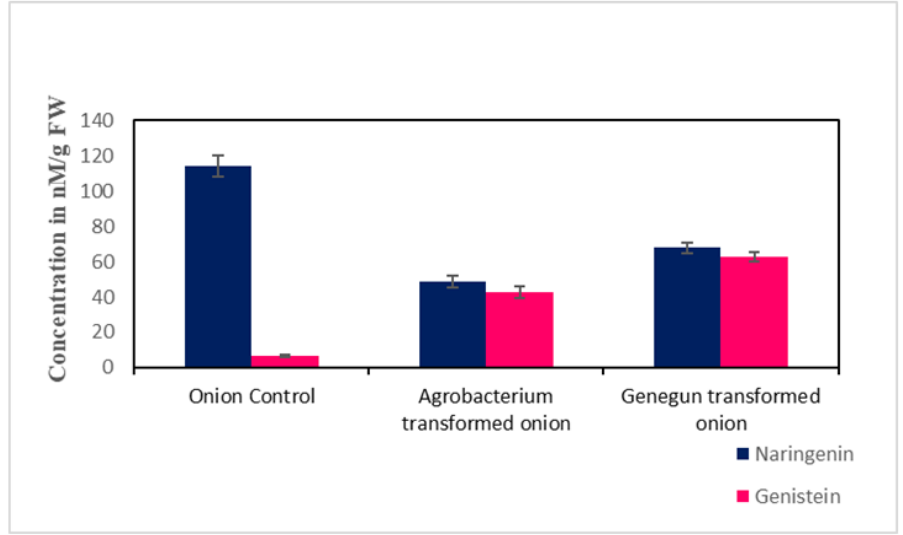
Figure 4. Quantification of naringenin and genistein in control and transformed in vitro grown onion lines. The HPLC analysis showed the presence of naringenin in control (wild type onion) and genistein accumulation was observed in Agrobacterium and biolistic transformed onion lines.